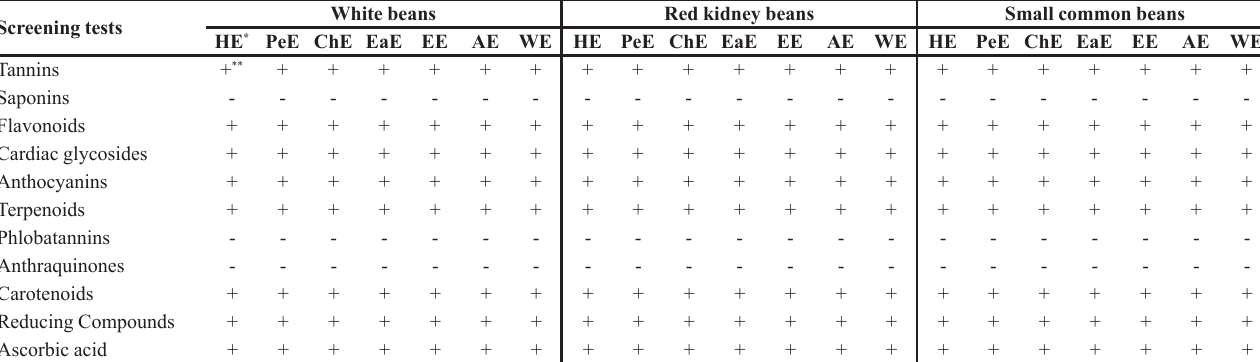
TABLE I - Phytochemical screening of bean seeds extracts in various solvents Screening tests